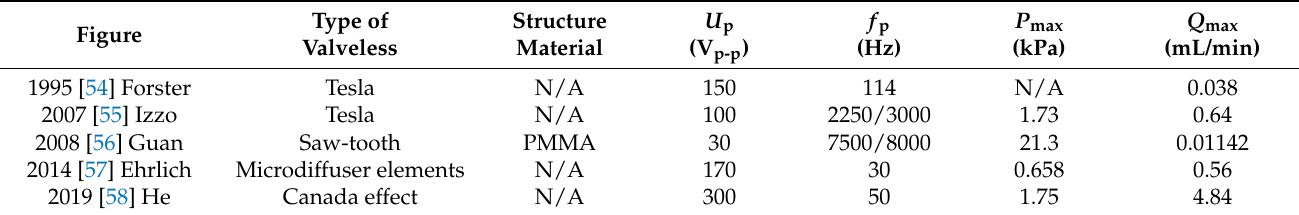
Table 3. Summary of properties for the valveless piezoelectric pump with special flow tubes.